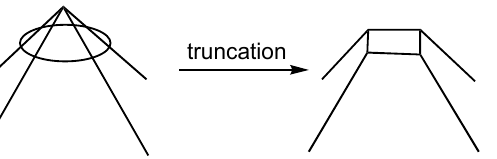
Figure 5. Schematic representation of the truncation of a degree 4 vertex to give a new tetragonal face.